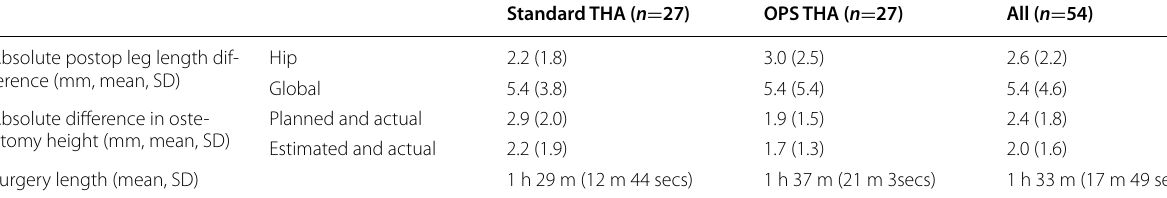
Table 4 Further secondary outcome